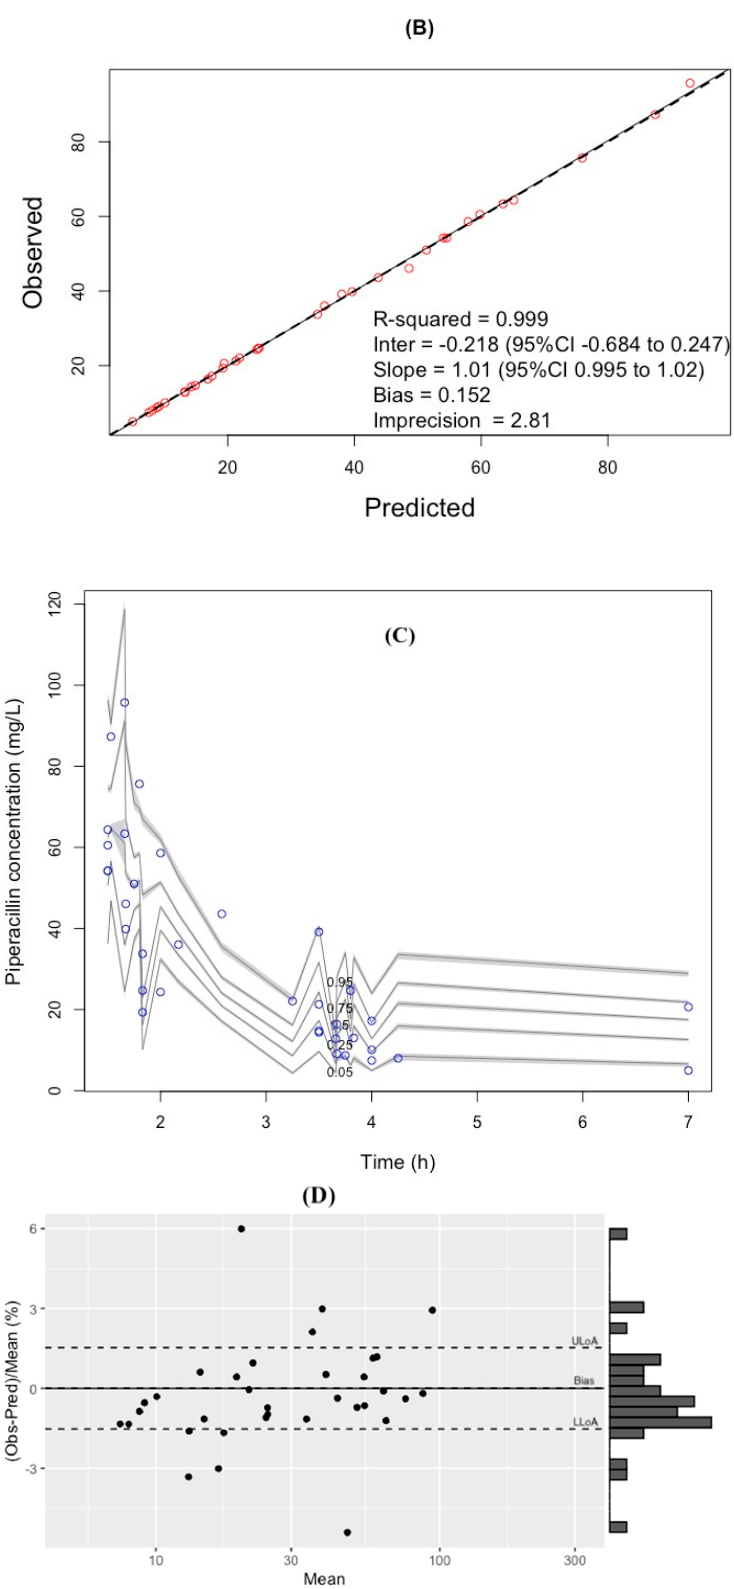
Figure 1. Internal validation. Observed versus population-predicted ( A ), and individual-predicted ( B ), concentration diagnostic plots, visual predictive check ( C ); (shaded areas represent quantiles distribution ranging from 0.05 to 0.95) and Bland-Altman residual plot ( D ) for individual-predicted data with a Bias of 0.01%, ULoA (+1.96SD) of 1.53% and LLoA ( − 1.96SD) of − 1.52%. Table 2. Estimates of piperacillin pharmacokinetic parameters for the final covariate model.